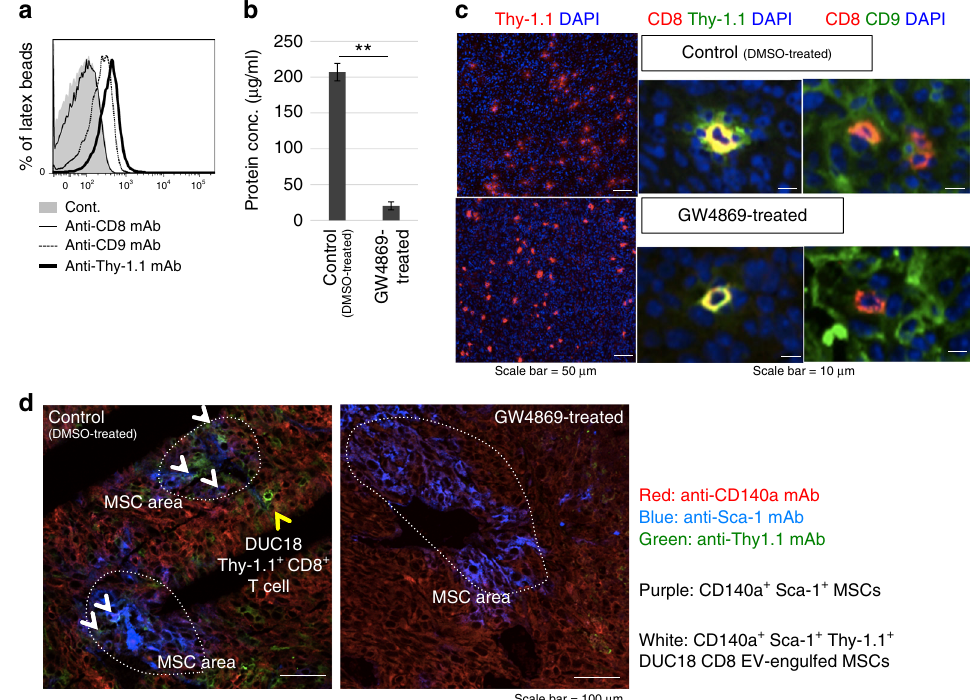
Fig. 6 EV production by adoptive transferred tumour-speci fi c CD8 + T cells. a Cultured Thy-1.1 + DUC18 CD8 EV bound to latex beads were stained with the indicated mAbs, and subjected to fl ow cytometric analysis. b EV proteins from the supernatant of Thy-1.1 + DUC18 CD8 + T cells cultured with/without GW4869 (DMSO treatment as a control) were measured by BCA assay (** p < 0.01; error bars indicate SEM) ( n = 3). The data were analysed by a two- tailed unpaired Student t -test. c Thy-1.1 + DUC18 CD8 + T cells cultured with/without GW4869 were transferred intravenously into CMS5a tumour-bearing BALB/c mice ( n = 6 per group). The next day, resected CMS5a tumours were sectioned and stained with the indicated FITC-conjugated or PE-conjugated mAbs and DAPI ( c ), or PE-conjugated CD140a-, FITC-conjugated Thy-1.1- and APC-conjugated Sca-1-speci fi c mAbs ( d ). The stained tumour sections were observed by fl uorescent microscopy ( c ) or confocal laser scattering microscopy ( d ). Each photo is a representative image from 3 – 5 areas. The dotted circles and arrows indicate MSC areas (purple) and Thy-1.1 + EV-engulfed MSCs (white), cultured cells were subjected to fl ow cytometric analysis using murine anti-CD4 (GK1.5), CD8 (53 – 6.7), TCRV β (H57 – 597), TCRV β 8.3 (1B3.3), CD9 (MZ3), CCR7 (4B12), FasL (Kay-10), PD-1 (RMP1-30), CD40L (MR1) or TIM-3 (RMT3 – 23) mAb, or human CD4 (OKT4), CD8 (RPA-T8) and TCR αβ (IP26)-speci fi c mAbs (all from Biolegend). The obtained culture supernatants (approximately 500 mL) were fi rst centrifuged at 10,000× g for 20min, fi ltrated through 0.45- and 0.22- μ m fi lters, and subjected to ultra fi ltration to concentrate the sample to 100 mL (Kvick Lab Packet